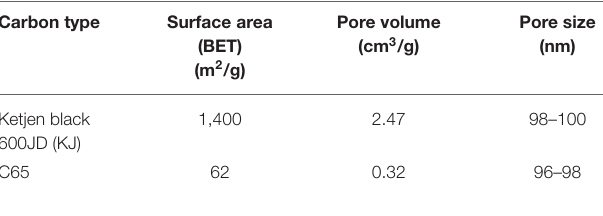
TABLE 4 | Measured surface area and pore volume of KJ and C65 carbons.